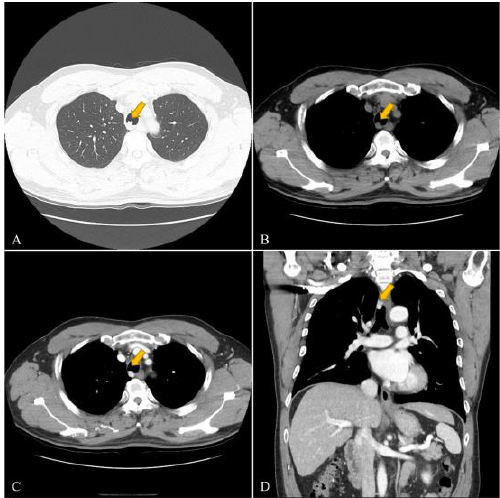
Figure 1. 53-year-old male with tracheal glomus tumor. ( A ) CT lung window setting images; ( B ) pre- contrast enhanced image; ( C ) post-contrast enhanced image; and ( D ) coronal post-contrast